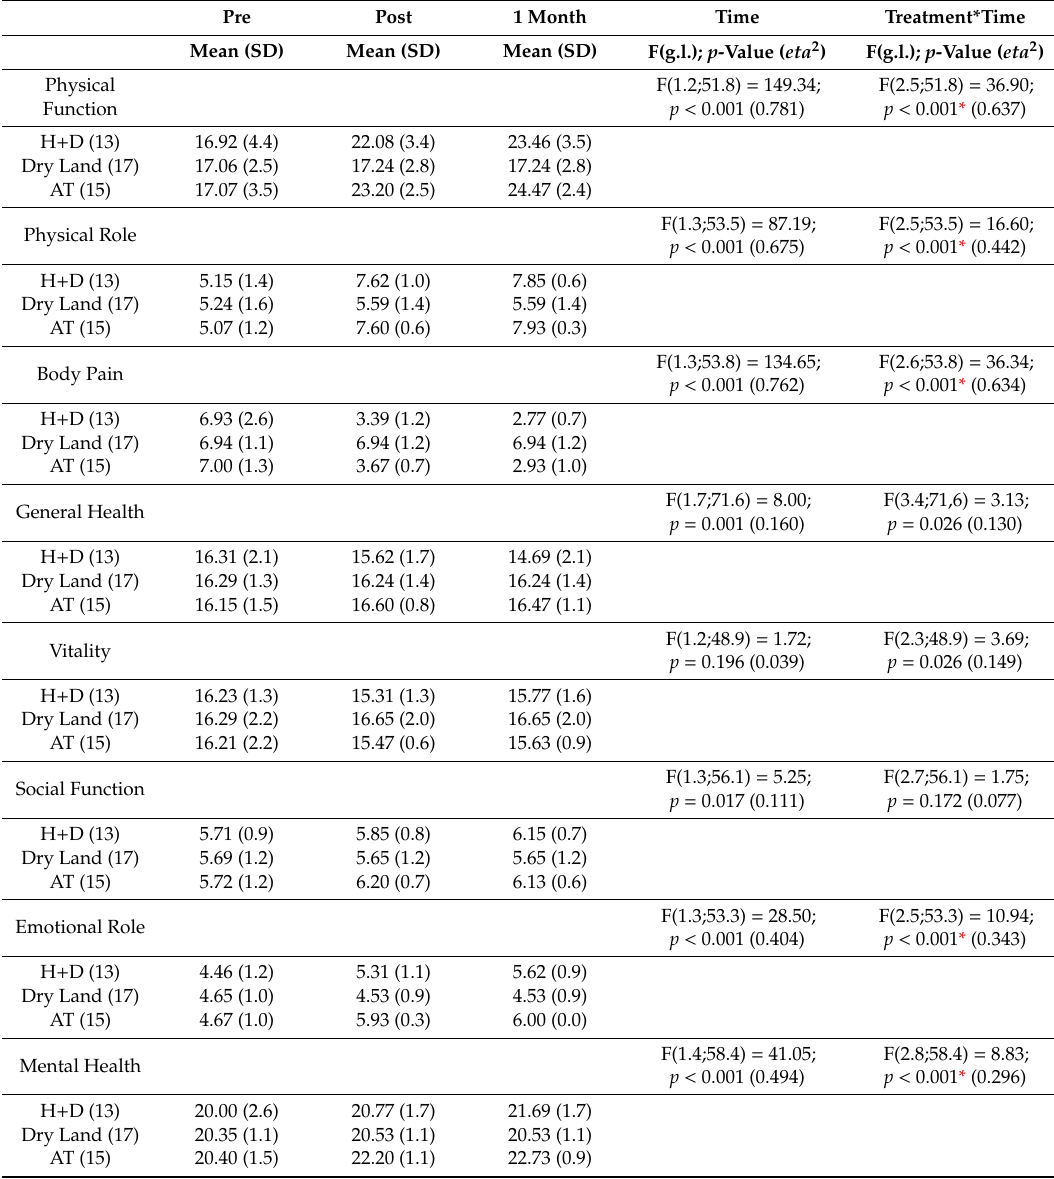
Table 2. Values obtained on the